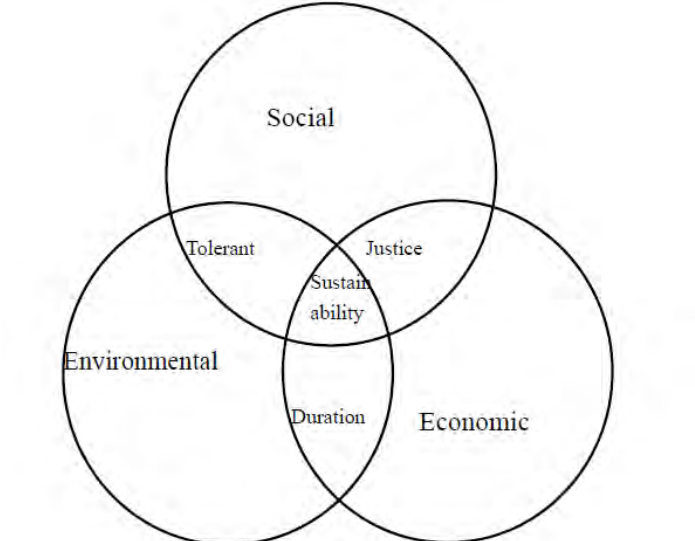
Figure 2. Graph of sustainability branches Source:The issue of “The Concept of Sustainability in Contemporary Architecture andIts Significant Relationship with Vernacular Architecture of Iran” p 134